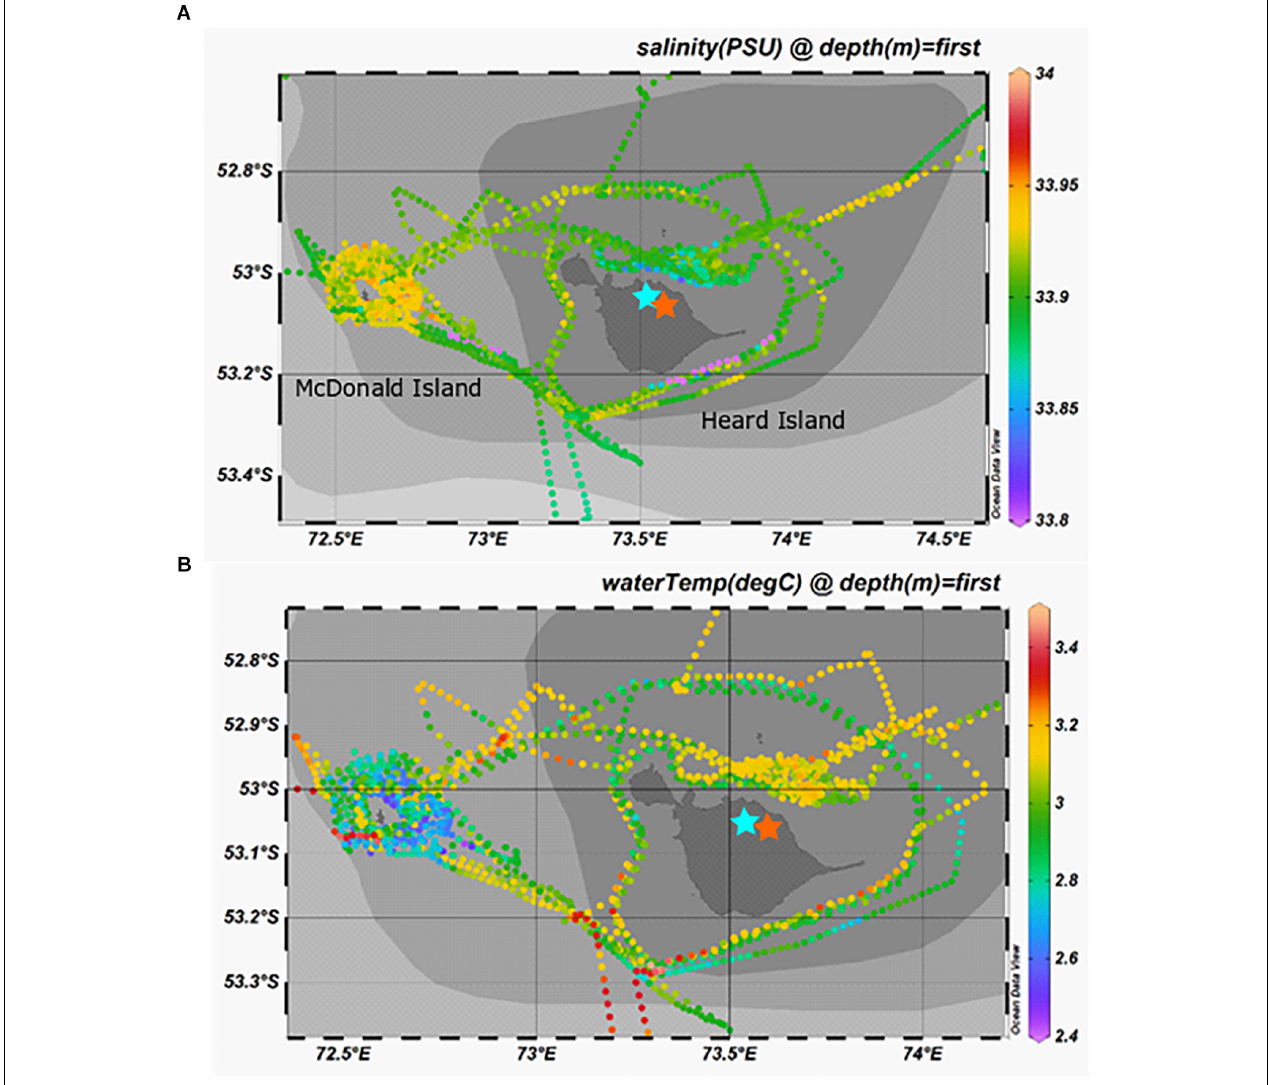
FIGURE 7 | Surface salinity (A) and temperature (B) taken from the underway sensors during the voyage. Note the parcel of fresh (aqua-blue) surface waters to the north of Heard Island, directly adjacent to outflow of Downes (blue star) and Ealey (orange star) marine terminating